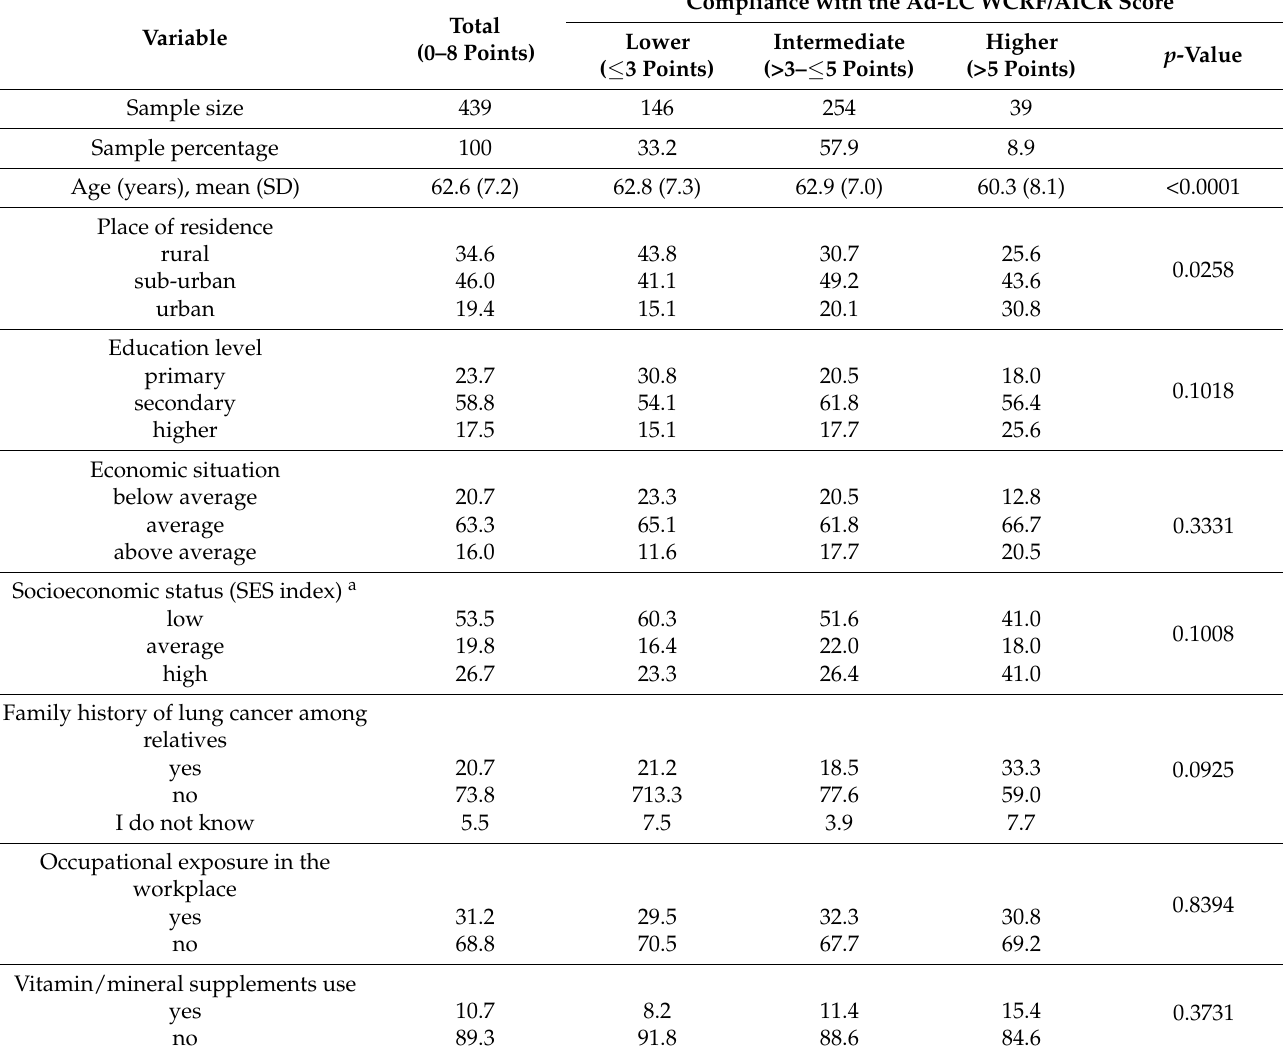
Table 5. Baseline characteristics of the cancer-control sample by categories of compliance with the Ad-LC WCRF/AICR Score